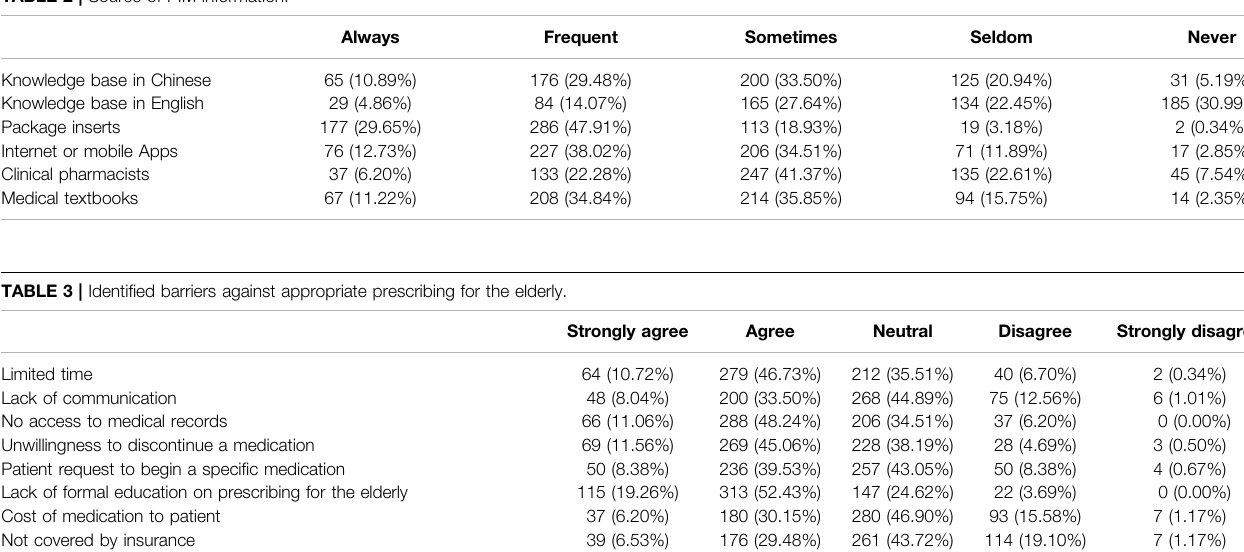
TABLE 2 | Source of PIM information.